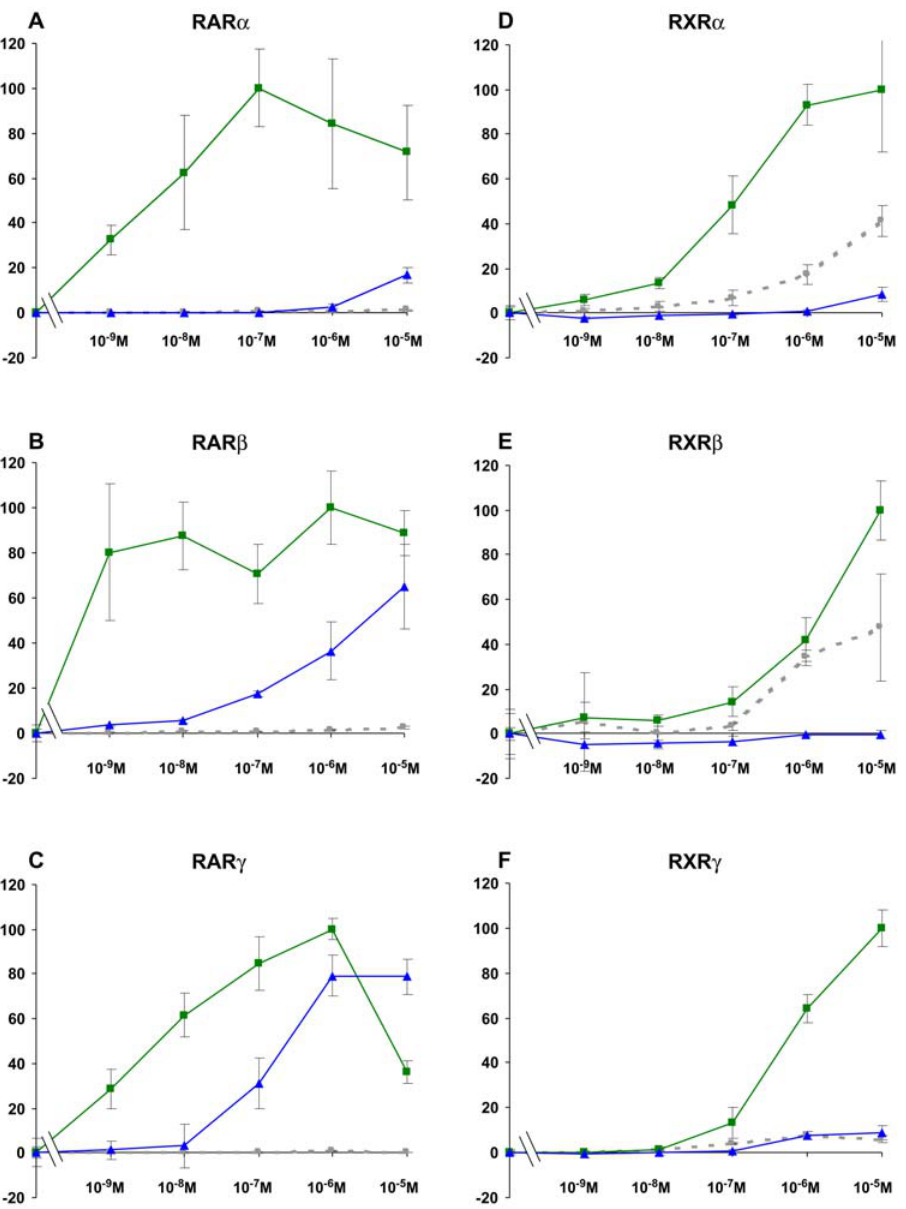
Figure 5. DTAB selectively activates RAR b and RAR c receptors. RA showed high efficiency in activating the RAR and RXR receptors. DTAB was a potent activator of RAR b and RAR c , but showed reduced efficiency towards RAR a and RXRs. Hek293T cells were transfected with a luciferase reporter plasmid, a b -gal transfection-control plasmid and an RA receptor plasmid, as indicated. Cells were treated with 10 2 9 M to 10 2 5 M concentrations of DTAB or RA at 24 hours after transfection and harvested at 48 hours post transfection for luciferase and b -gal reporter assays. RA treated cells are shown by solid green squares and line and DTAB treated cells by solid blue triangles and line. Control cells transfected with only the luciferase and b -gal reporter plasmids (with no RA receptor plasmid) and treated with various concentrations of RA are shown by dashed gray line and gray circles. All luciferase readings were normalized to b -gal transfection controls. b -gal readings remained approximately equal throughout each experimental set showing equal transfection efficiency and cell viability. X-axis denotes RA or DTAB concentration. Y-axis represents arbitrary luminescence values. All RA and DTAB activities were normalized to the respective no-treatment controls. The maximum activity was set to 100% and all values calculated